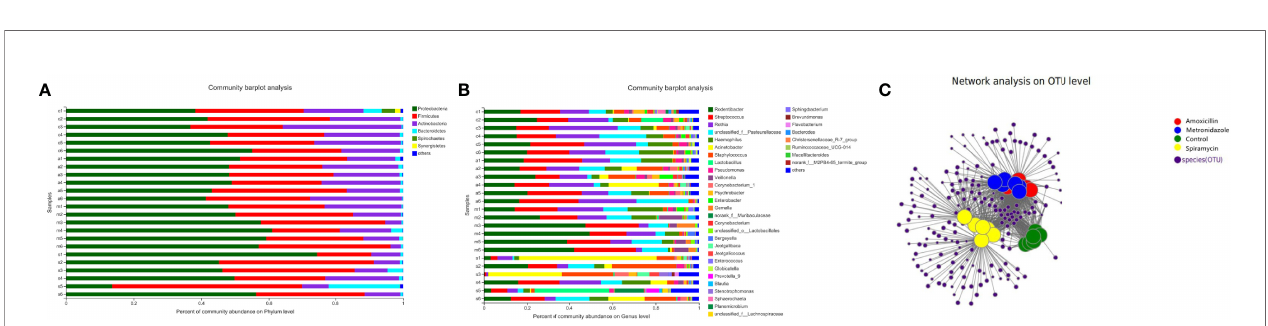
FIGURE 4 | Oral bacterial community at the phylum (A) and genus (B) level. (Phyla or genera with abundance of less than 1% abundance were merged into ‘ others ’ . (C) Network-based analysis of oral microbial communities in Amoxicillin, Metronidazole, Control, Spiramycin groups.